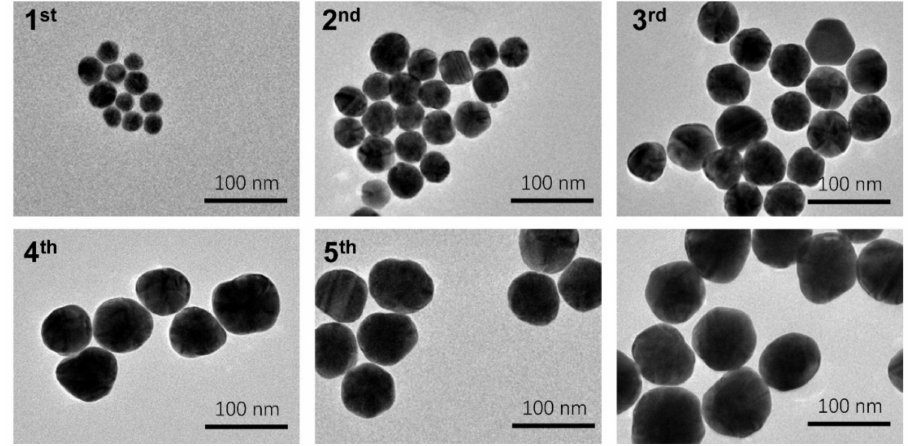
Figure 1. TEM images of AuNPs with different growth steps.